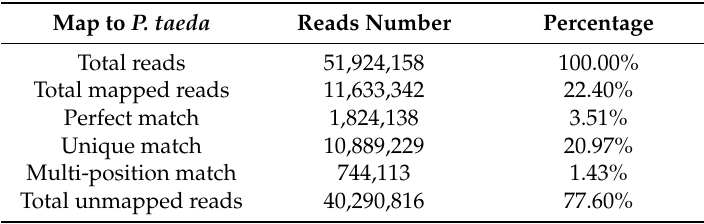
Table 1. Summary of mapping statistics to P. taeda